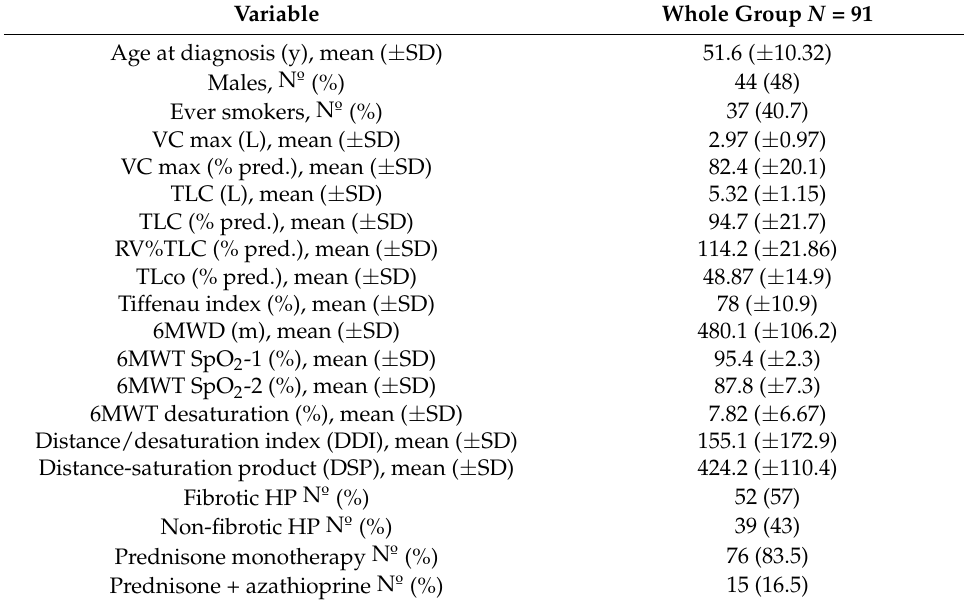
Table 2. Baseline characteristics of the study group.